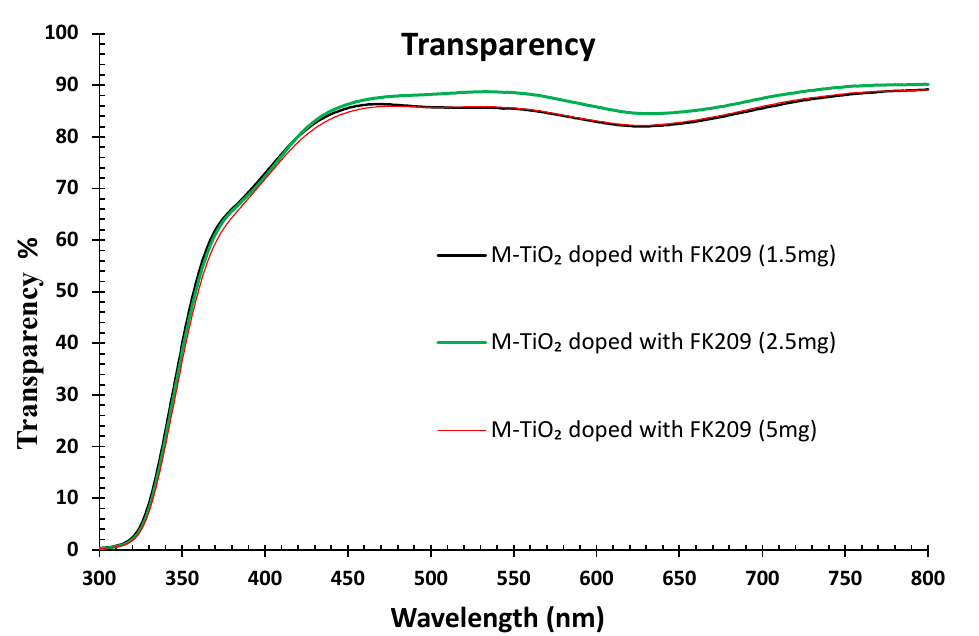
Figure 13. Transparency of the M-TiO 2 doped with 1.5-mg, 2.5-mg and 5-mg concentrations of FK209 cobalt.